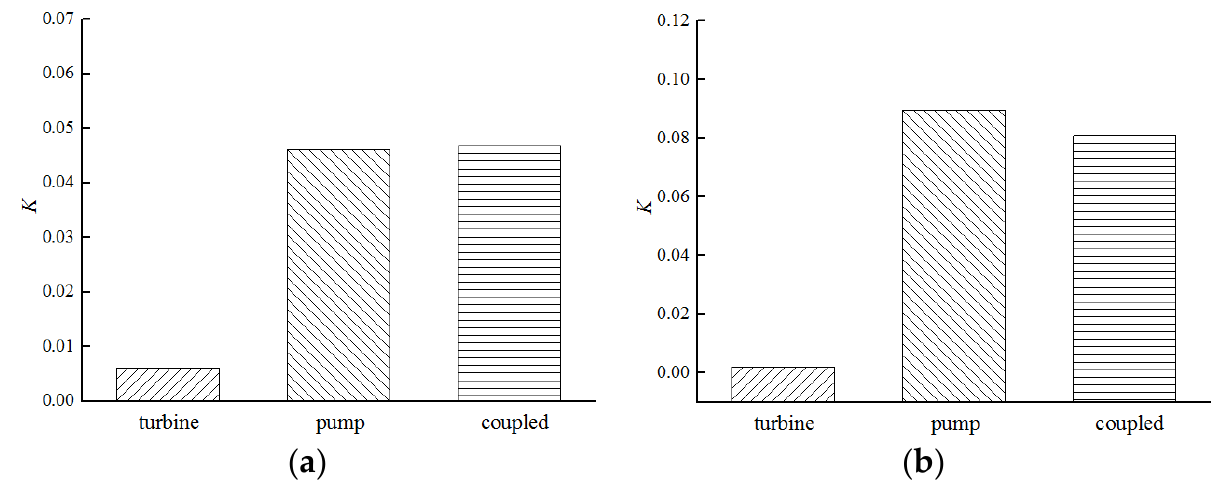
Figure 18. Amplitude of radial hydraulic force fluctuations. ( a ) Impeller. ( b ) Housing. According to the fluctuation frequencies in Figures 11 and 16, the force fluctuations on the turbine and pump at the frequency of 15 f R result in the resonance. Figure 19 shows the fluctuation amplitudes on the separate turbine, the separate pump and the turbopump. The amplitude at the resonant frequency is higher than that on the separate turbine and pump. However, as for the whole frequency domain, the force fluctuation at the frequency of 15 f R is not severe, as shown in Figure 20. The amplitude at the frequency of 5 f R is highest, and close to the fluctuation amplitude on the separate pump. This illustrates that the force characteristics in the frequency domain are also determined by the